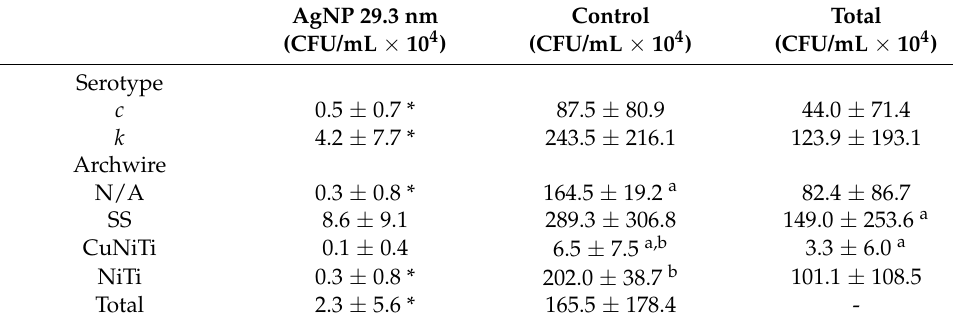
Table 2. The anti-Adherence activity of AgNP on S. mutans